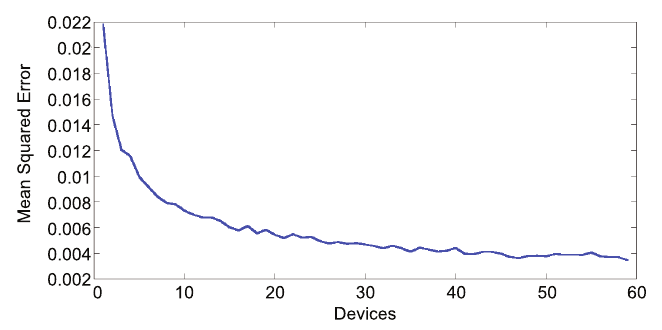
Figure 15. MSE of the traffic occupancy per samples per hour (opposite